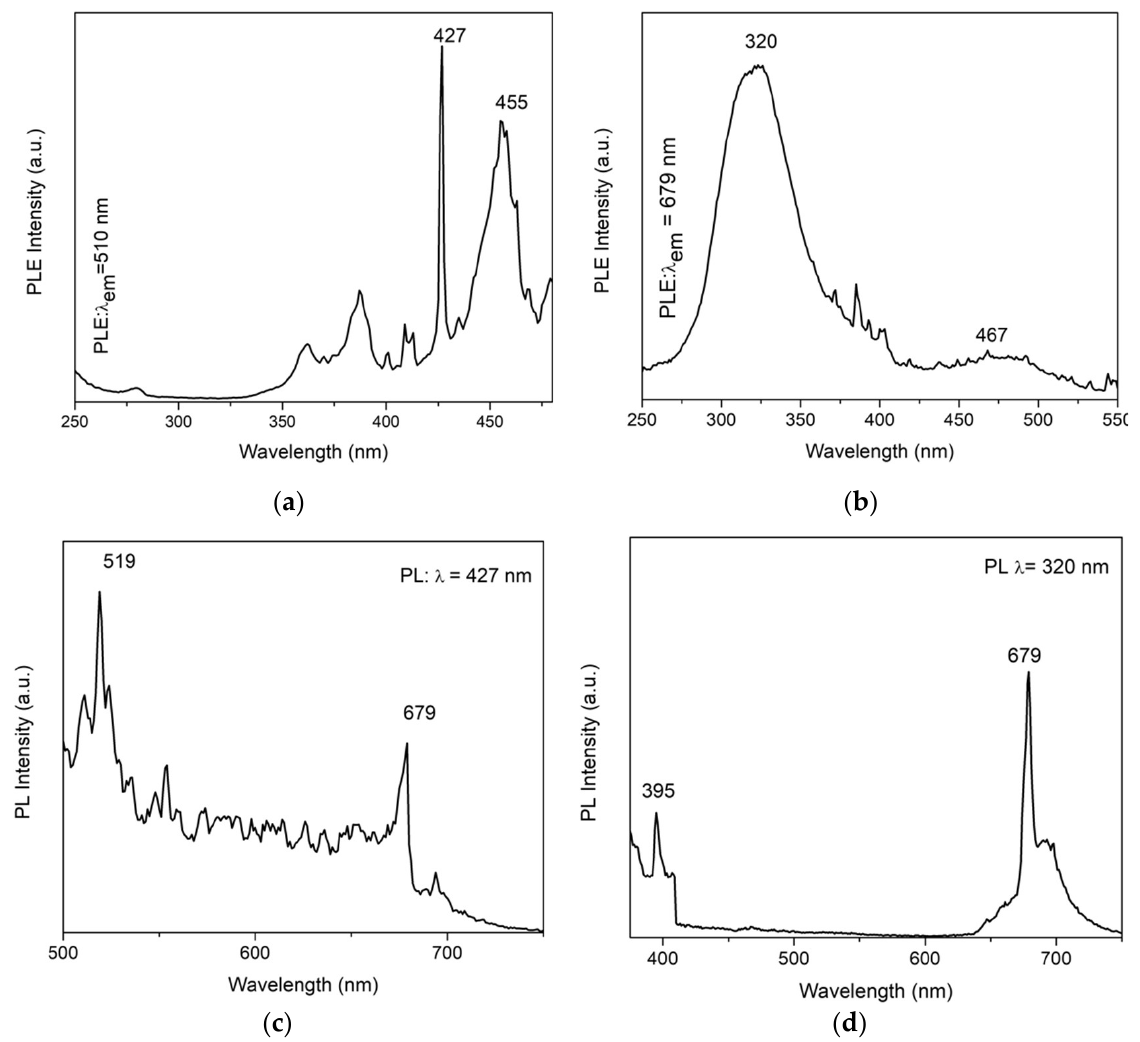
Figure 11. ( a ) PLE spectrum of ZnAl 2 O 4 :Mn annealed at 1400 ℃ at 510 nm; ( b ) PLE spectrum of ZnAl 2 O 4 :Mn annealed at 1400 ℃ at 679 nm; ( c ) PL spectrum of ZnAl 2 O 4 :3Mn annealed at 1400 ℃ and excited by 427 nm; ( d ) PL spectrum of ZnAl 2 O 4 : Mn annealed at 1400 ℃ and excited by 320 nm.